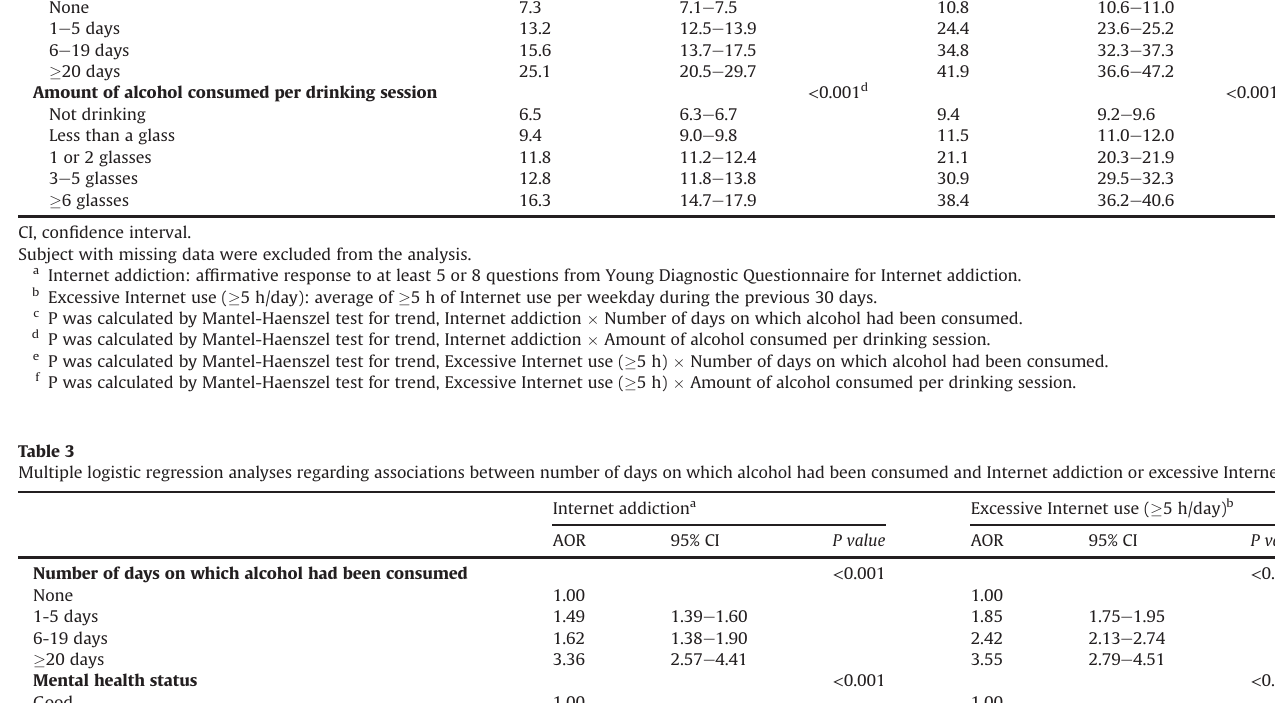
Number of days on which alcohol had been consumed